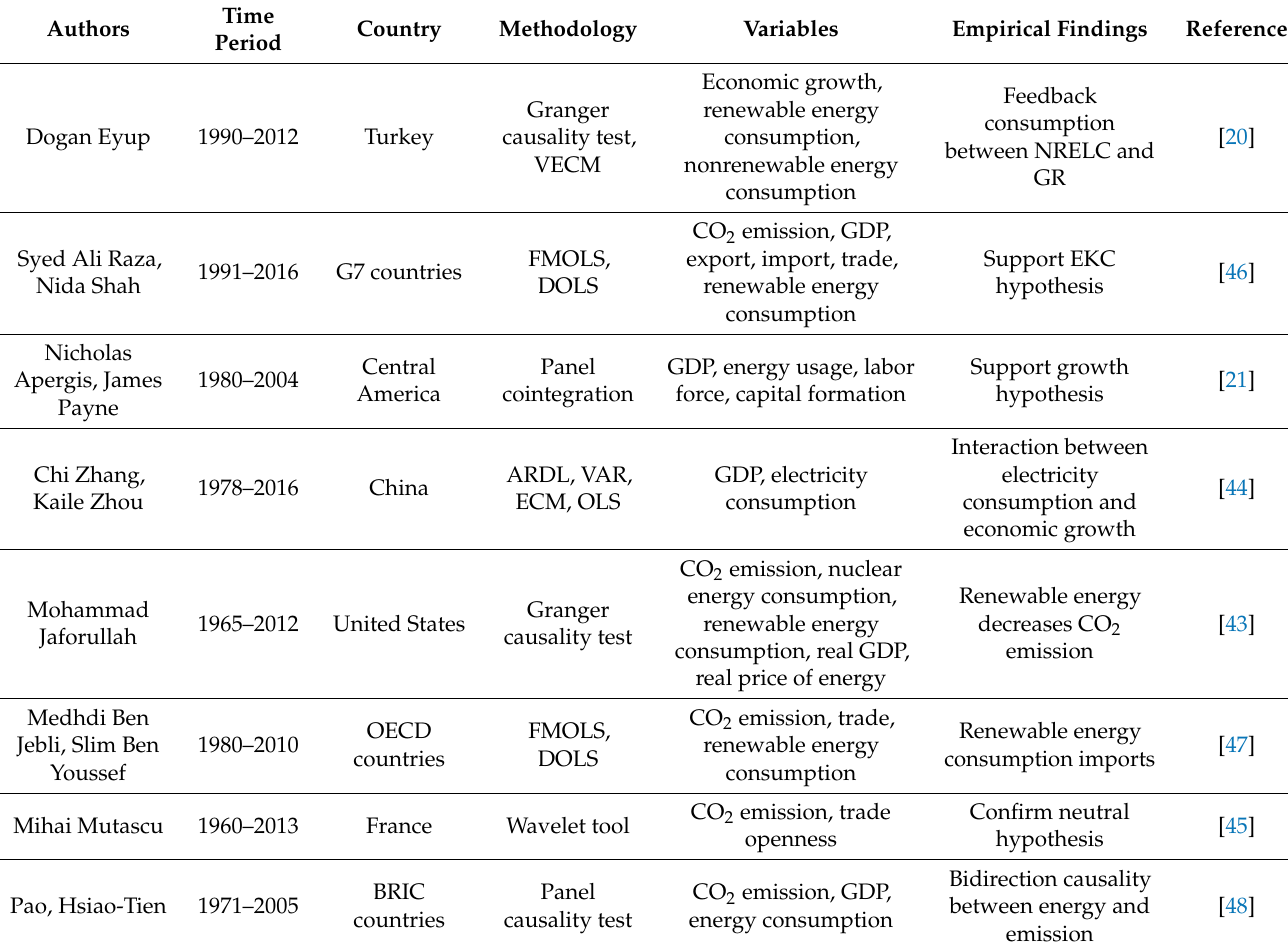
Table 1. Literature review